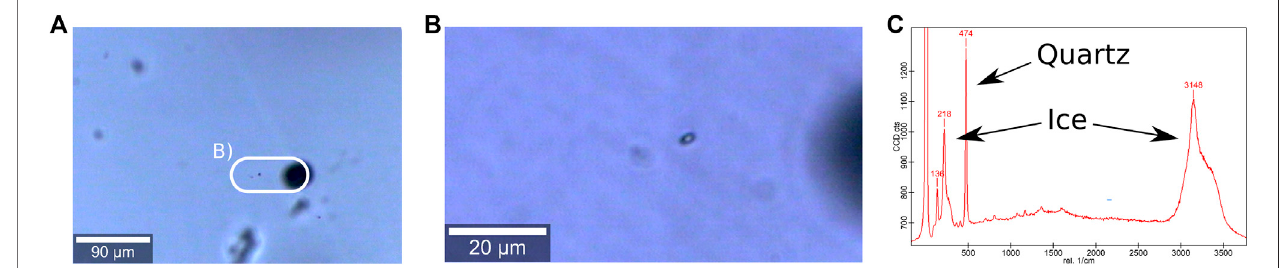
FIGURE 6 | Micro-inclusions and derived Raman spectra (Stoll and Weikusat, 2020). (A) Micro-inclusions 500 µm below the sample surface. Large black spheres are bubbles, small dark dots are micro inclusions. The white bordure indicates the area shown in (B) . (B) Detailed view of (A) , two micro-inclusions in slightly different depths are visible. (C) Raman spectra of the focused micro-inclusion shown in (B) . The signals of surrounding ice and inclusion are marked. The high peak on the left represents the used laser. Figure concept compiled after Figure 6 from Scherer and Snyder (1977), Figure 2 from Fukazawa et al. (1997), Figure 2 from Ohno et al. (2005), Figures 1 and 3 from Ohno et al. (2006), Figure 2 from Eichler et al. (2017), and Figure 4 from Eichler et al.